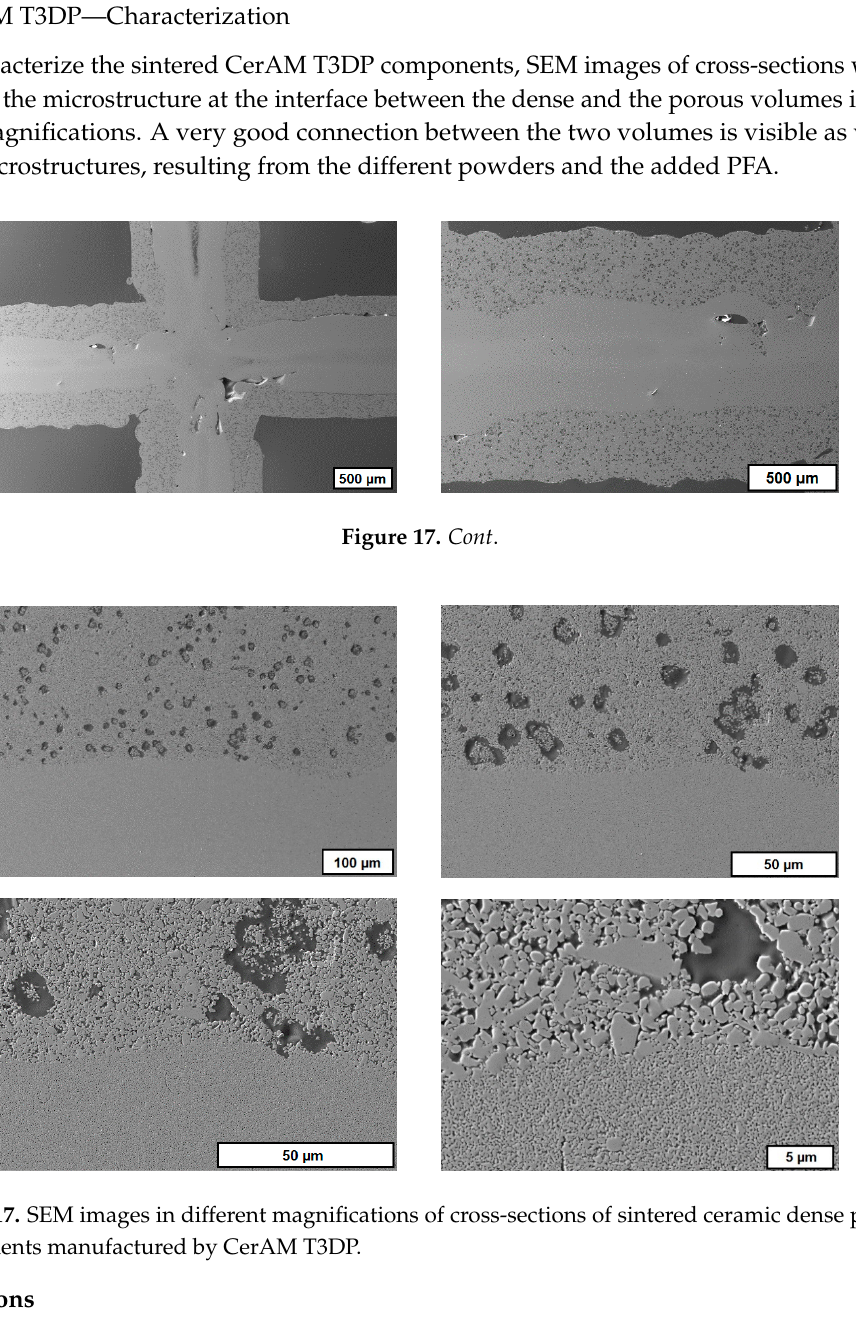
components manufactured by CerAM